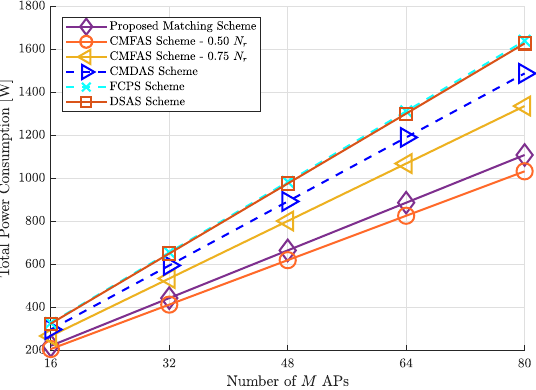
Figure 6. Total power consumption versus number of APs, where N r = 48 APs, N Q = 8, ρ = 23 dBm, and K = 8 UEs.